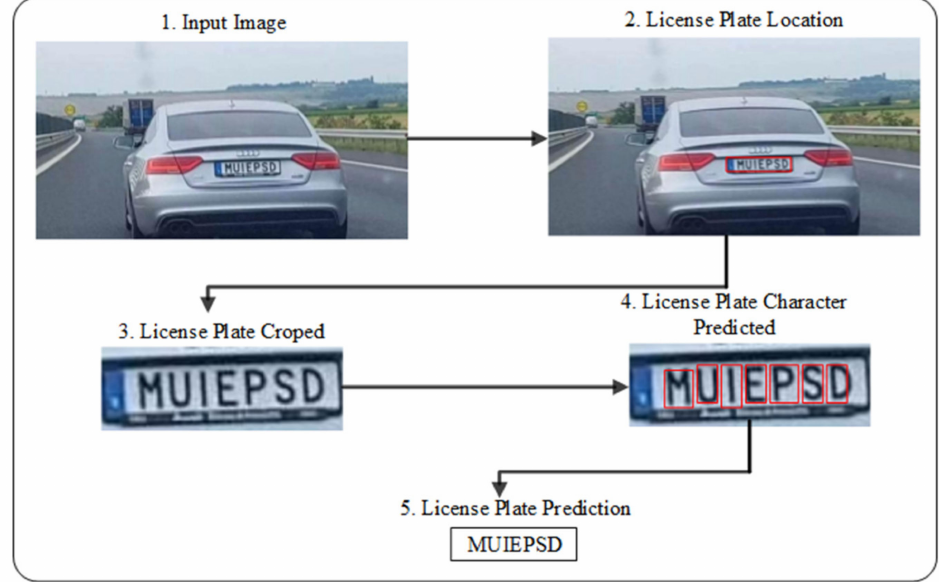
Figure 15. The flow of the license plate-based vehicle